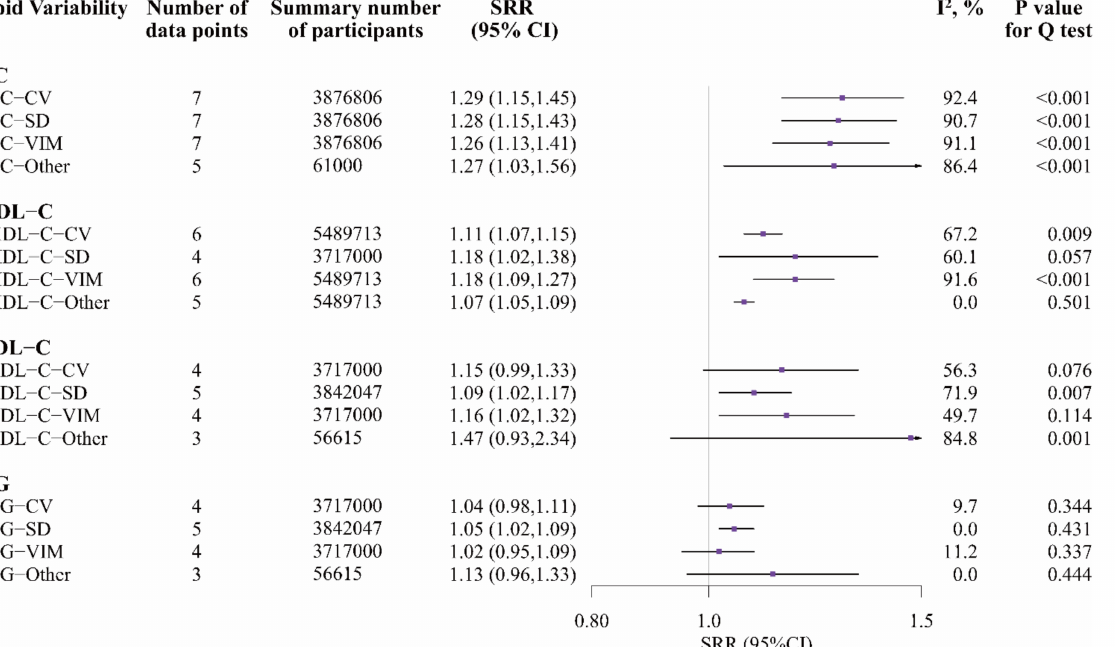
diabetes showed similar results for TC variability, HDL-C-CV, HDL-C-VIM,